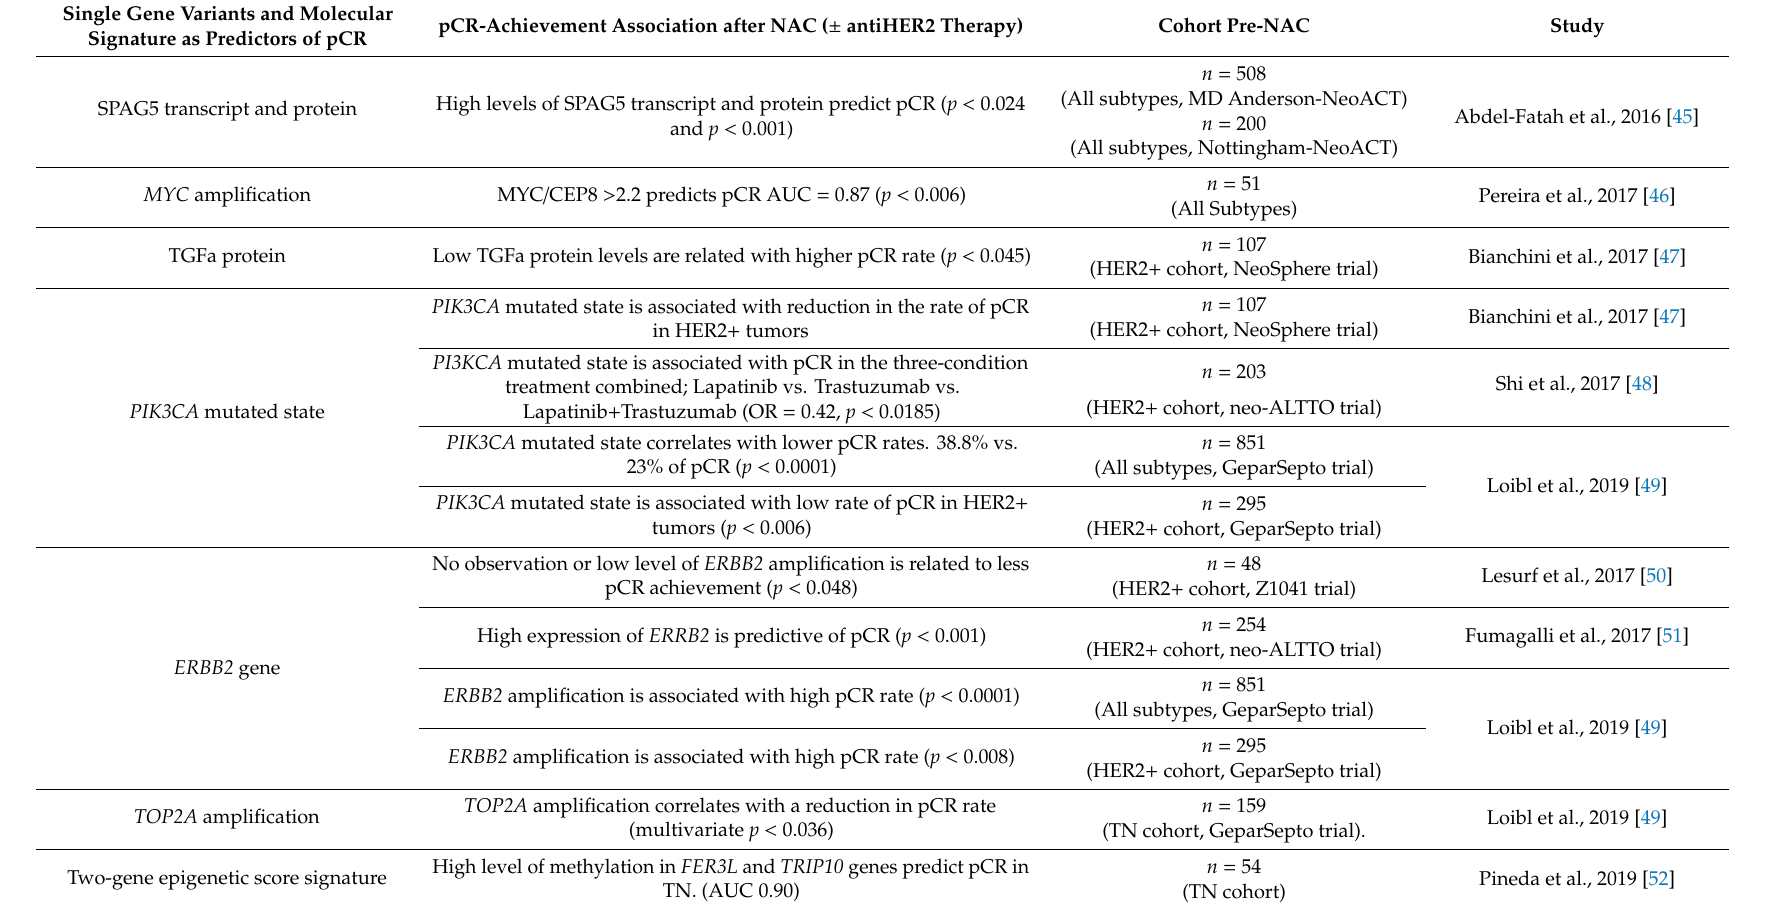
Table 3. Genomic, transcriptomic, and proteomic predictors of pCR